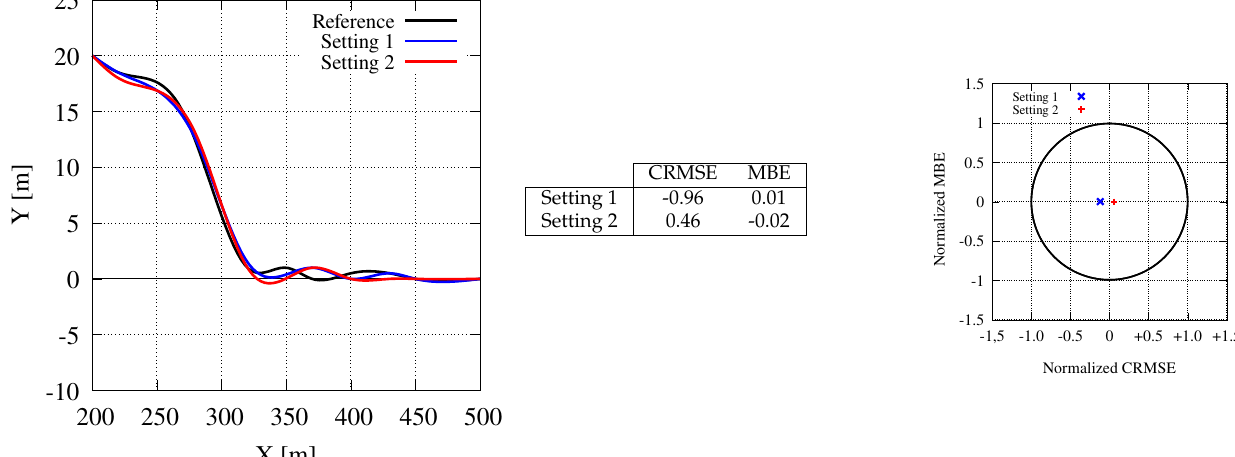
Figure 17. Generated paths for a back on track maneuver. The CPU trajectory (black color) is represented as a reference for the GPU one (blue and red colors, with Setting 1 and